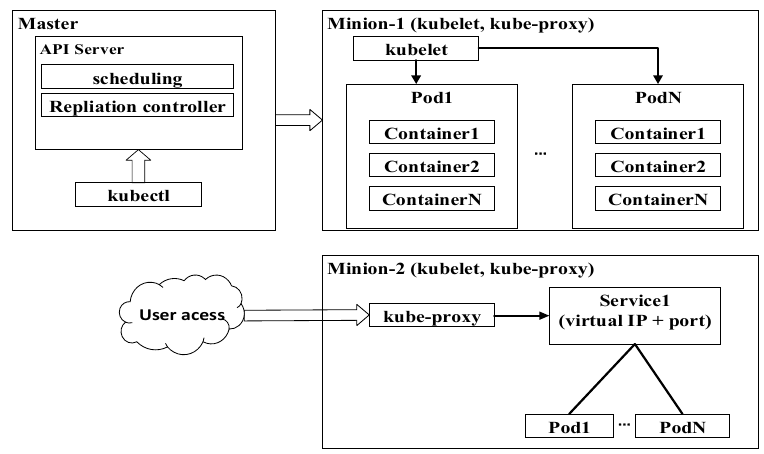
Figure 4. Kubernetes components for orchestrating containers distributed in minion nodes.